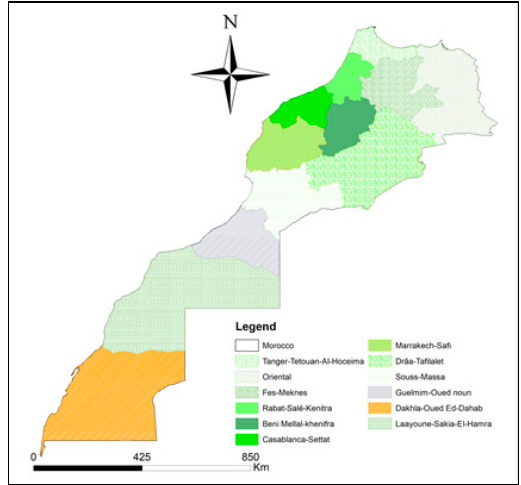
Figure 1. Political map of Morocco.